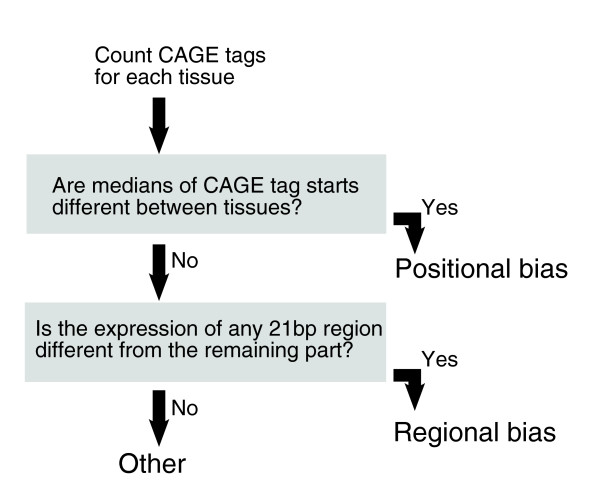
Classification of dynamic TSS usage within promoters. The classification flow of tag clusters. All of the examined tag clusters are classified into three categories - positional bias, regional bias, and others - based on CAGE tag counts from each tissue. bp, base pairs; CAGE, cap analysis of gene expression; TSS, transcription start site.